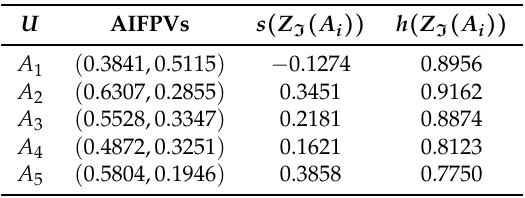
Table 3. AIFPVs and related measures in Case 1.